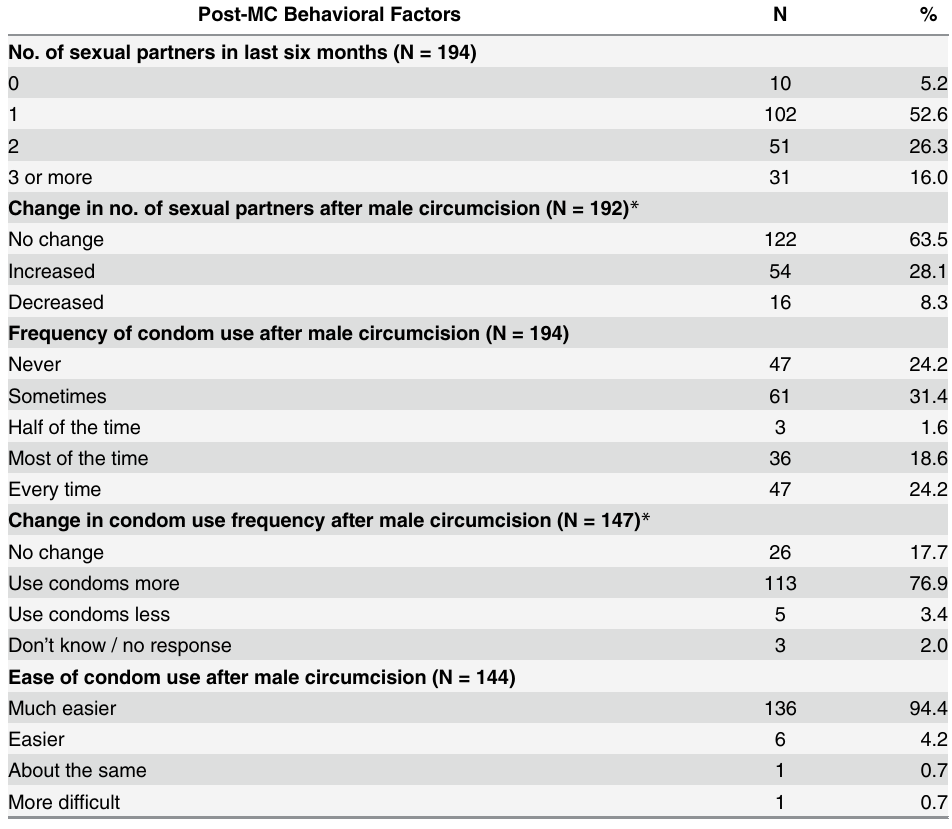
Table 2. Selected Sexual Behavior Features of Men Interviewed 2+ Years after ShangRing Male Cir- cumcision (N = 194). Post-MC Behavioral